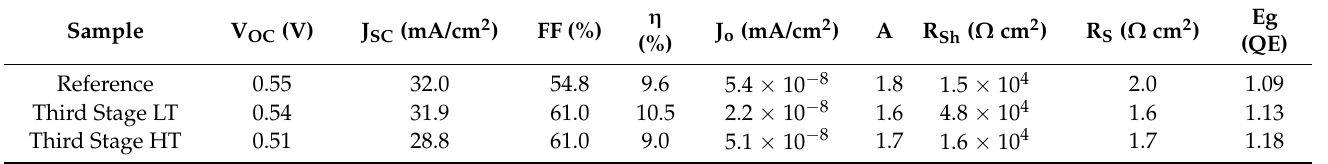
Table 5. Photovoltaic characteristics and diode parameters of the representative cells shown in Figure 8. Sample